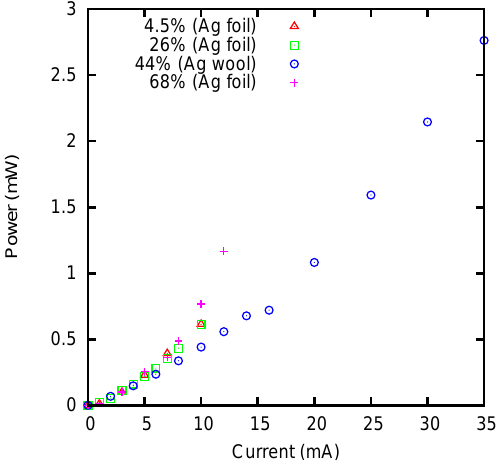
Figure 8. The average dissipated power during charge-discharge cycles in ZnCl The various data sets refer to different concentrations and different electrodes. The size of the electrodes is 1 × 1 cm; in the case of the Ag wool, this is the macroscopic dimension of the felt. The reported power is an average over five consecutive cycles; the standard deviation is less than 6%.